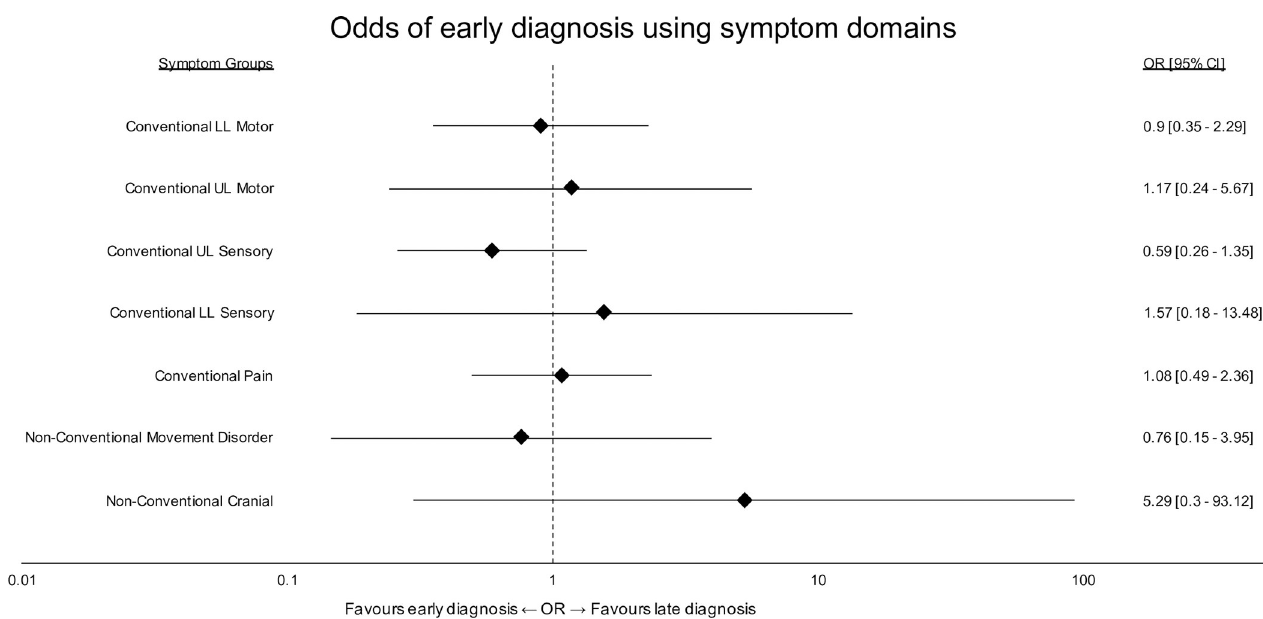
Fig 7. Odds of early diagnosis using symptom categories. A forest plot of individual odds ratios for each symptom category. Error bars represent 95% confidence intervals of the odds ratio. Categories with N � 1 have been left out for the purposes of clear illustration.